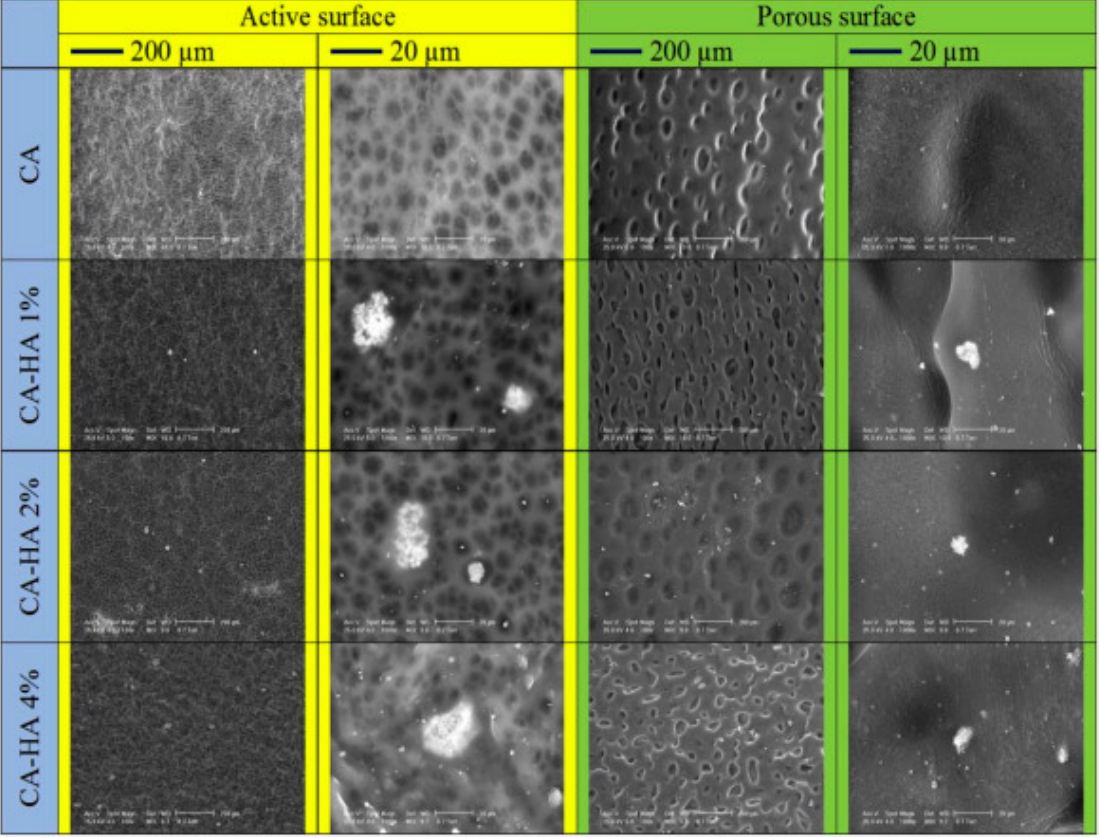
Figure 2 . SEM images of the cellulose acetate/hydroxyapatite membranes prepared by immersion Figure 2. SEM images of the cellulose acetate / hydroxyapatite membranes prepared by immersion precipitation (reproduced with permission from Ref. [52]). precipitation (reproduced with permission from Ref.